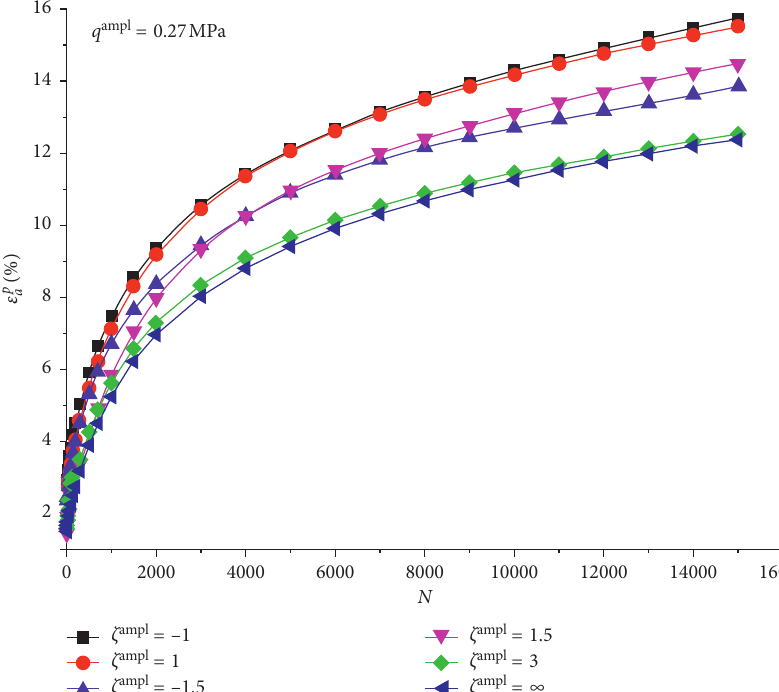
Figure 7: Axial accumulation strain with increasing loading cycle under different amplitude ratios.